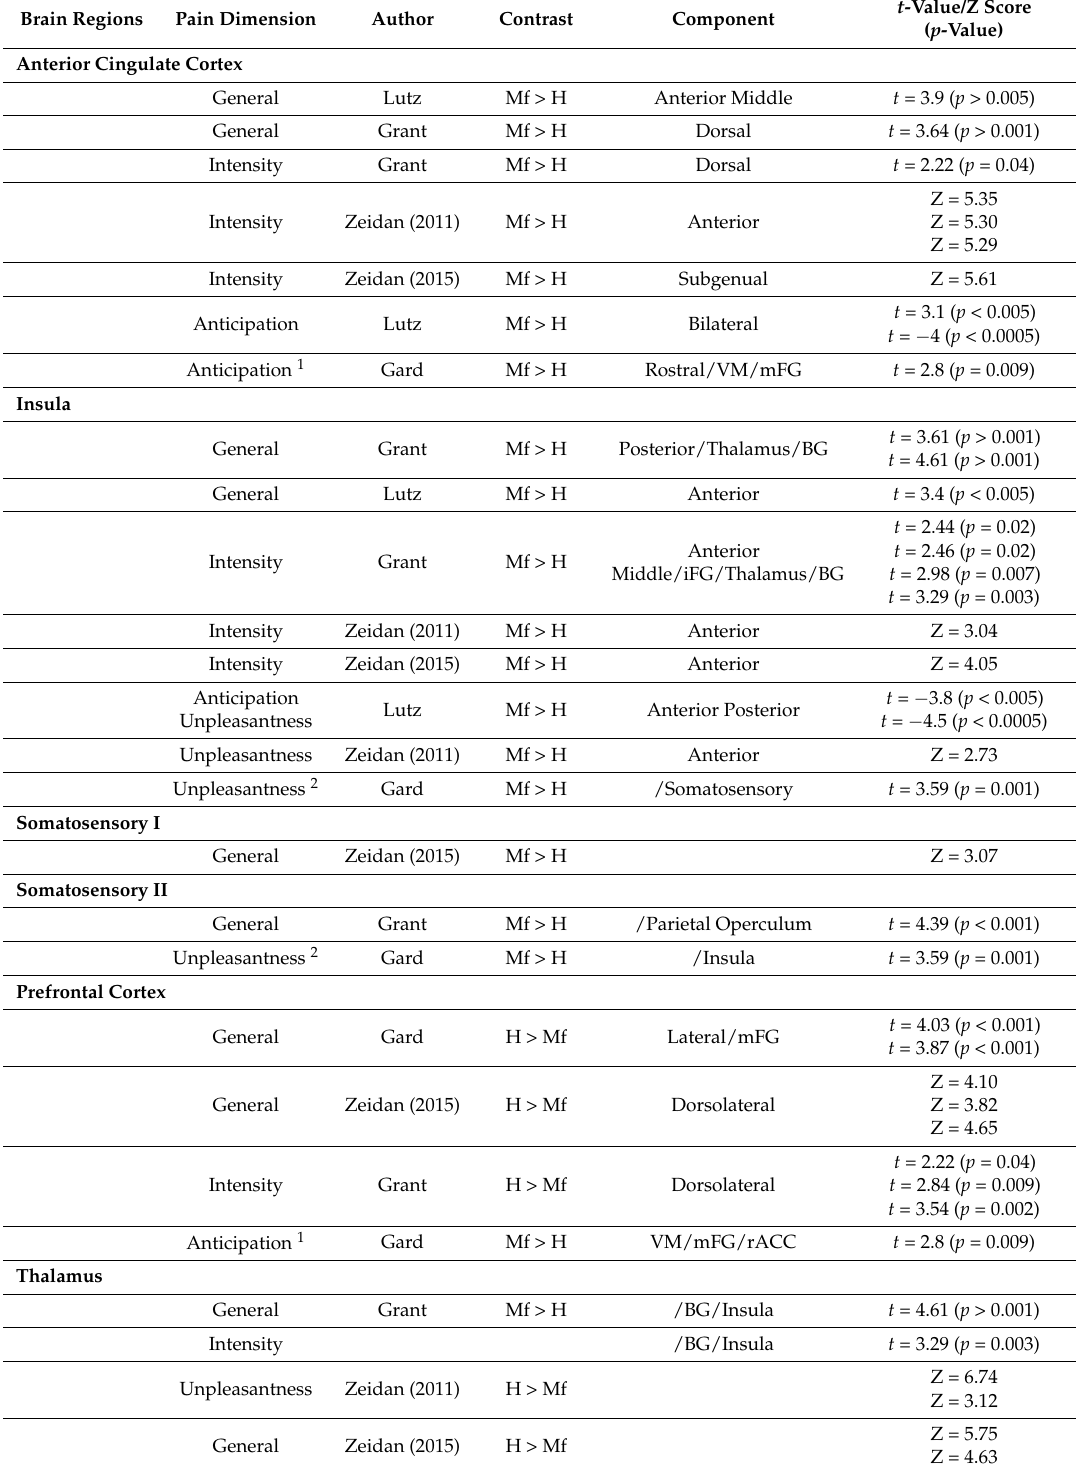
Table 2. Selected neural activity reported in included